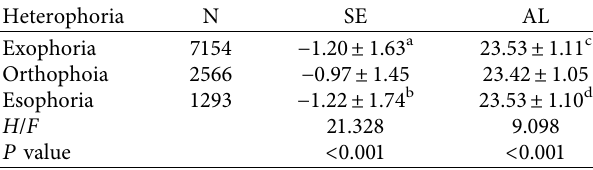
Significant differences ( P 0 . 001). 0 . 001). ∗ < < Table 3: SE and AL in children with different types of near